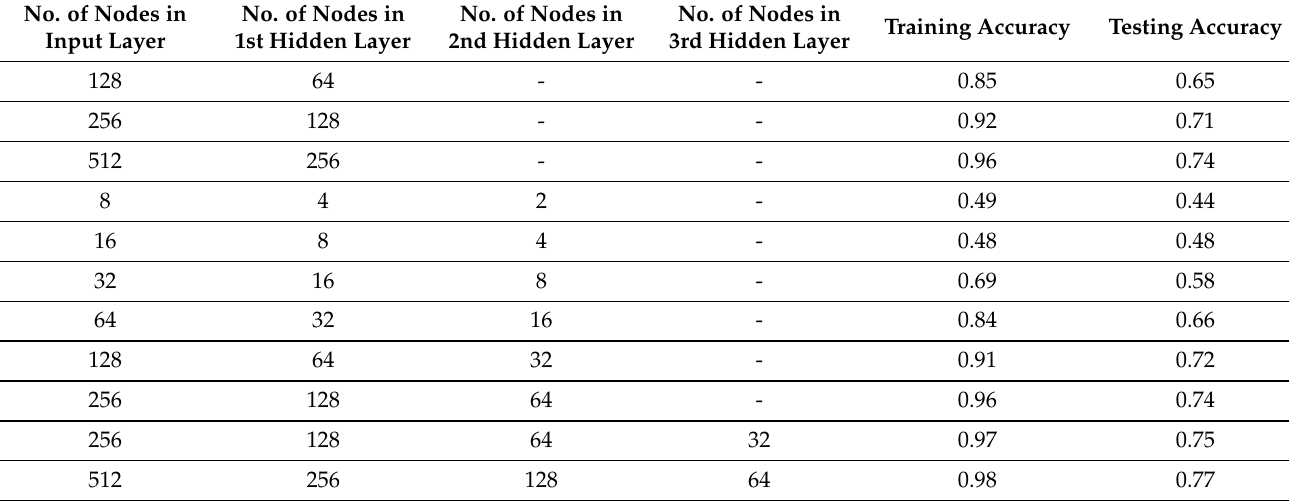
Table 2. The training and testing accuracies for different MLP